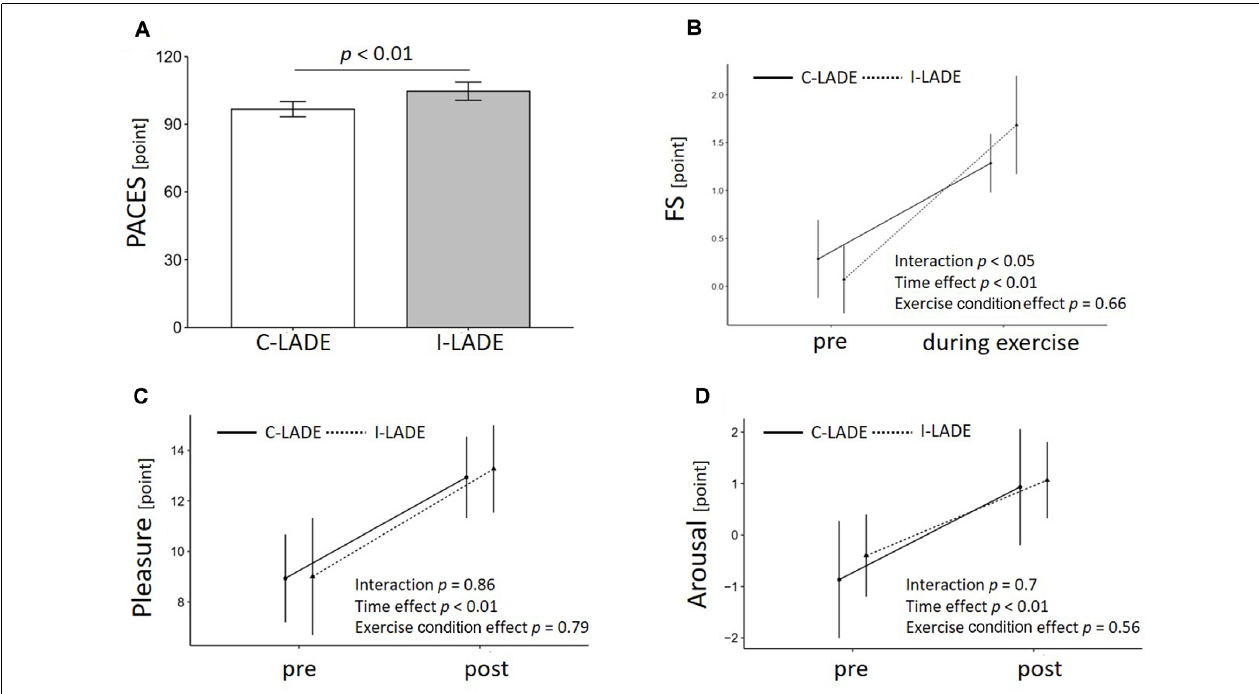
FIGURE 3 | Results of mood-related variable analysis. Means and standard deviations are shown. The p values in (A) show the results of the paired t -test. The p values in (B) , (C) , and (D) show the results of the two-way ANOVA with time and exercise condition as factors. PACES, Physical Activity Enjoyment Scale; FS, Feeling Scale; ANOVA, analysis of variance.